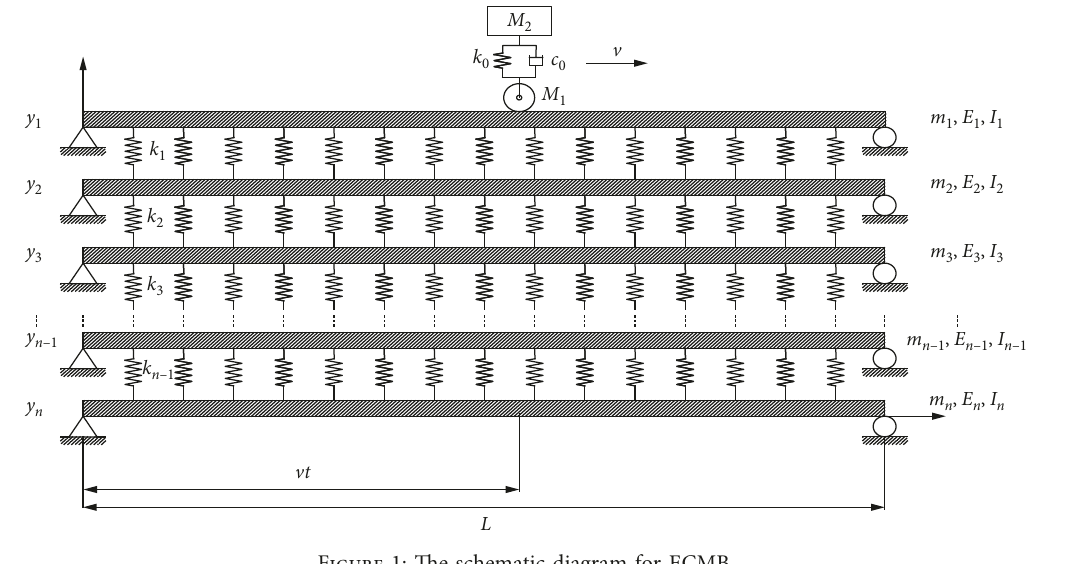
Figure 1: The schematic diagram for